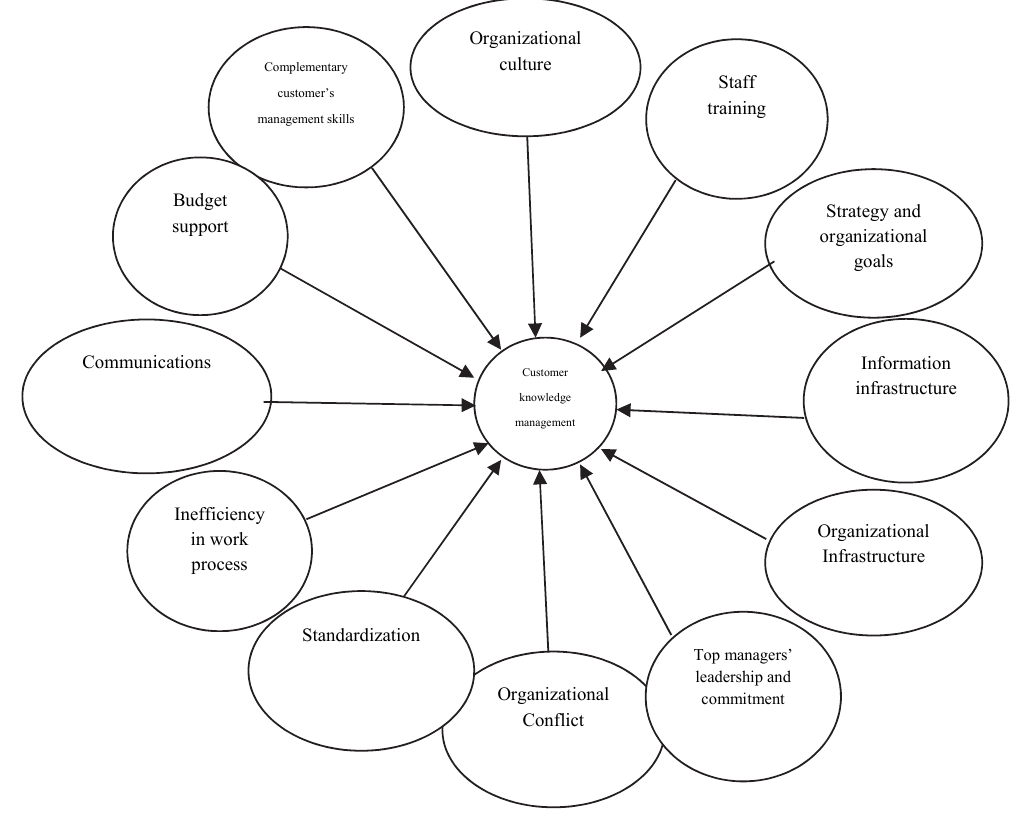
Fig. 1. The conceptual research model (Attafar et al.,